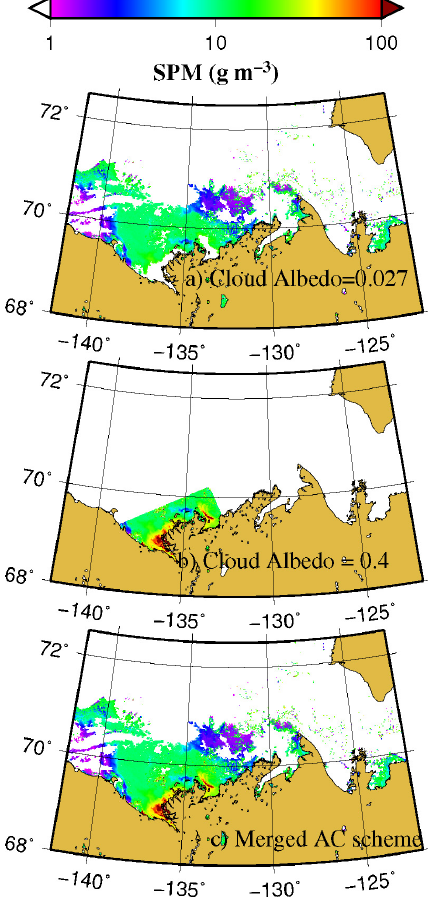
Figure 3. Example of processing (atmospheric corrections to re- trieve the remote-sensing reflectances at 555 and 748nm, then in- version of the 748 : 555 reflectance band ratio into SPM concentra- tion) applied to Level-1B MODIS-Aqua data from 4 July 2007: (a) NIR-SWIR atmospheric correction with default mask thresholds; (b) NIR-SWIR atmospheric correction with cloud-albedo threshold set to 0.4 (instead of 0.027) in the river delta zone; (c) merged prod- uct.